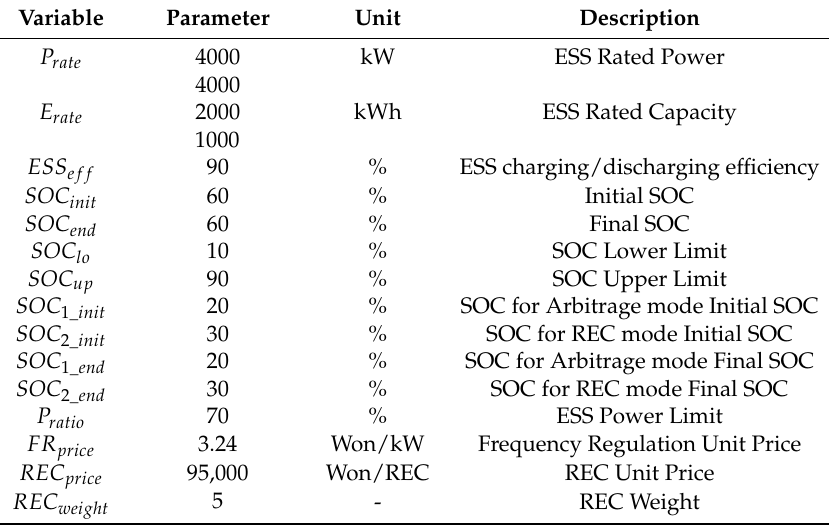
Table 2. Simulation parameters and applied values.